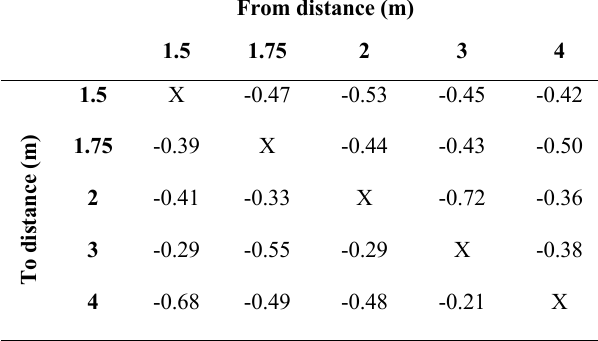
Table 1. Mean PCAs for Every Change in Distance.